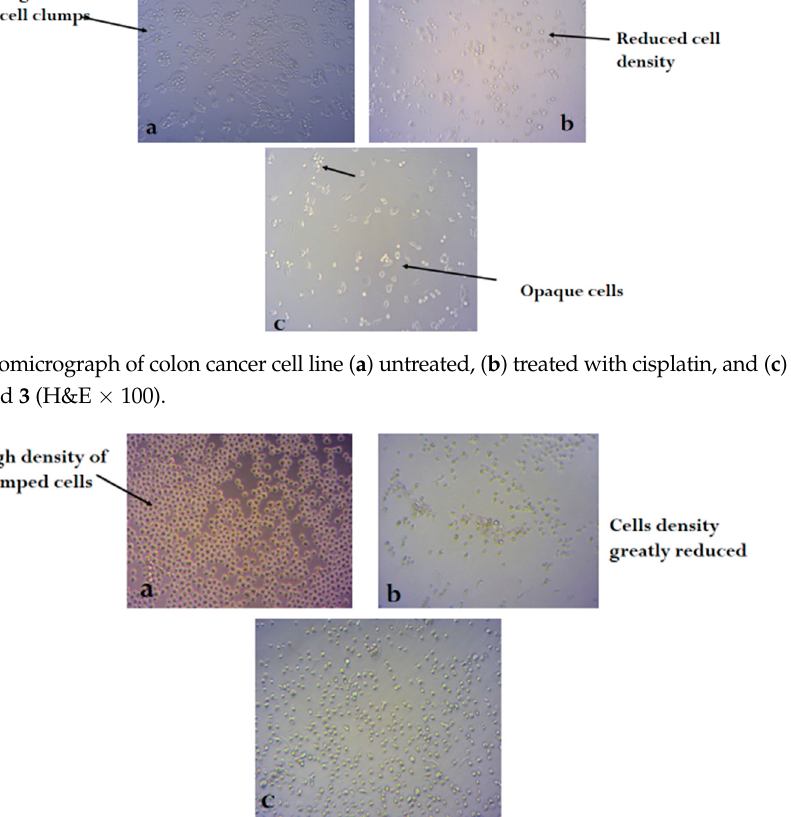
Figure 4. Photomicrograph of leukemia cancer cell line ( a ) untreated, ( b ) treated with cisplatin, and ( c ) treated with compound 3 (H&E x200).